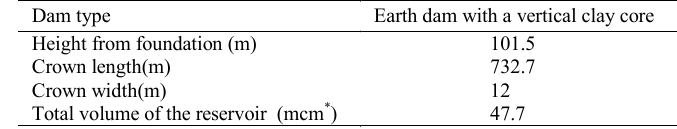
Table 1: Technical specifications of Gavi Dam (Puyab Consulting Engineers,